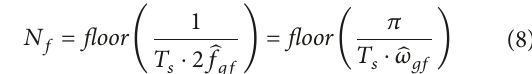
where N and 𝛼 = T